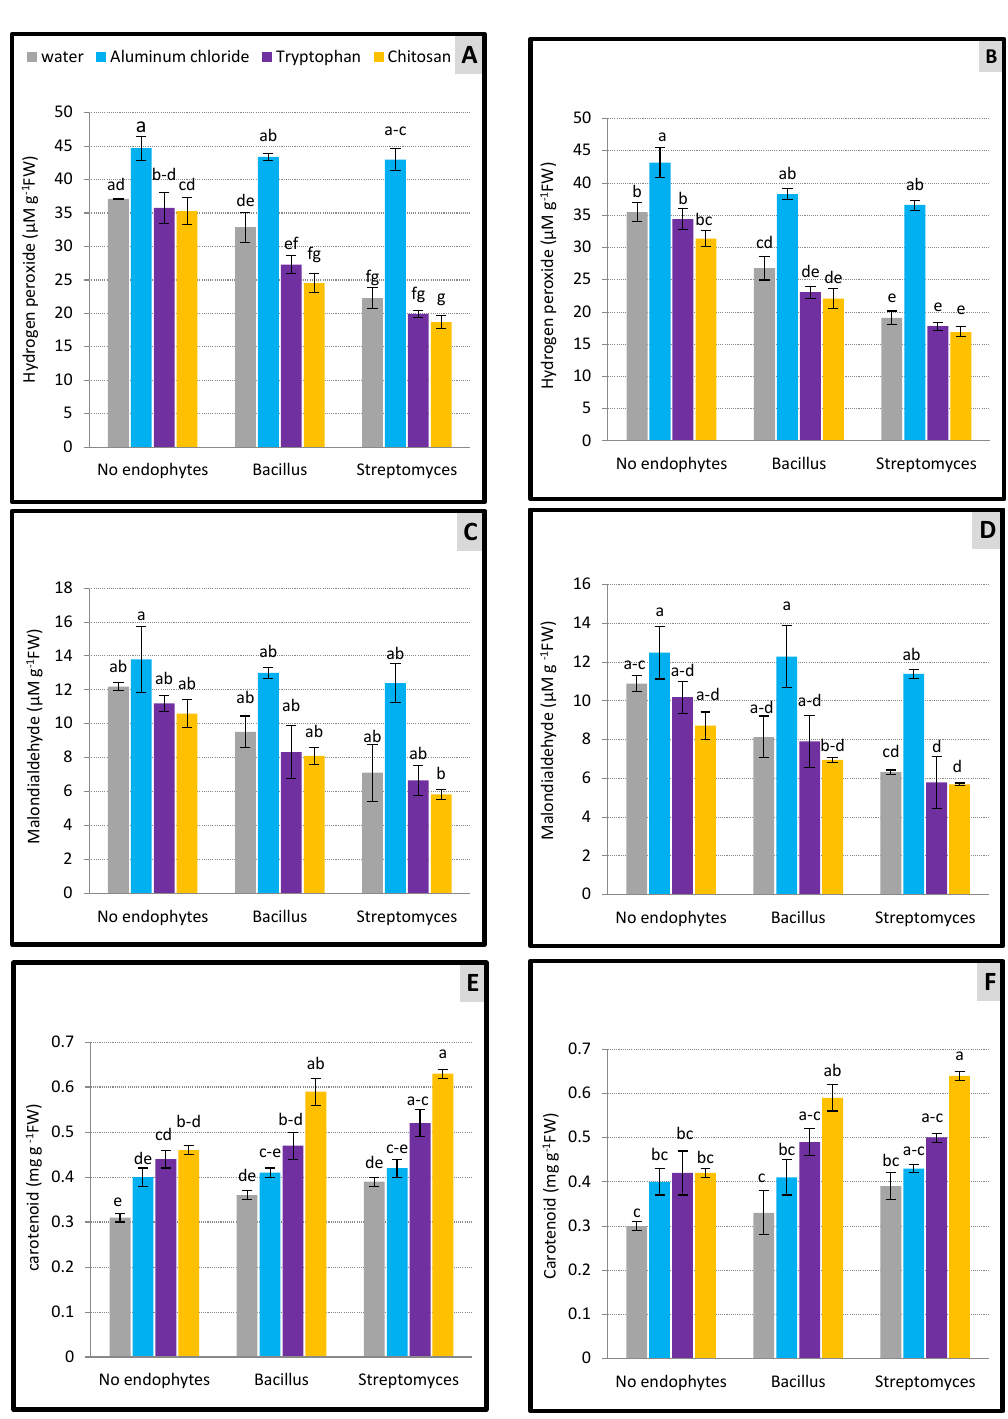
Figure 4. Interactive effect of endophytic microorganisms and abiotic elicitors on ( A , B ) hydrogen peroxide (µM g −1 FW), ( C , D ) malondialdehyde (µM g −1 FW), and ( E , F ) carotenoid (mg g −1 FW) in periwinkle plant shoot in both seasons (FW, fresh weight). Columns w the same letter in each chart are non-significantly ( p ≤ 0.05) different according to Tukey’s test. Means of five replicates are presented with ±SE.